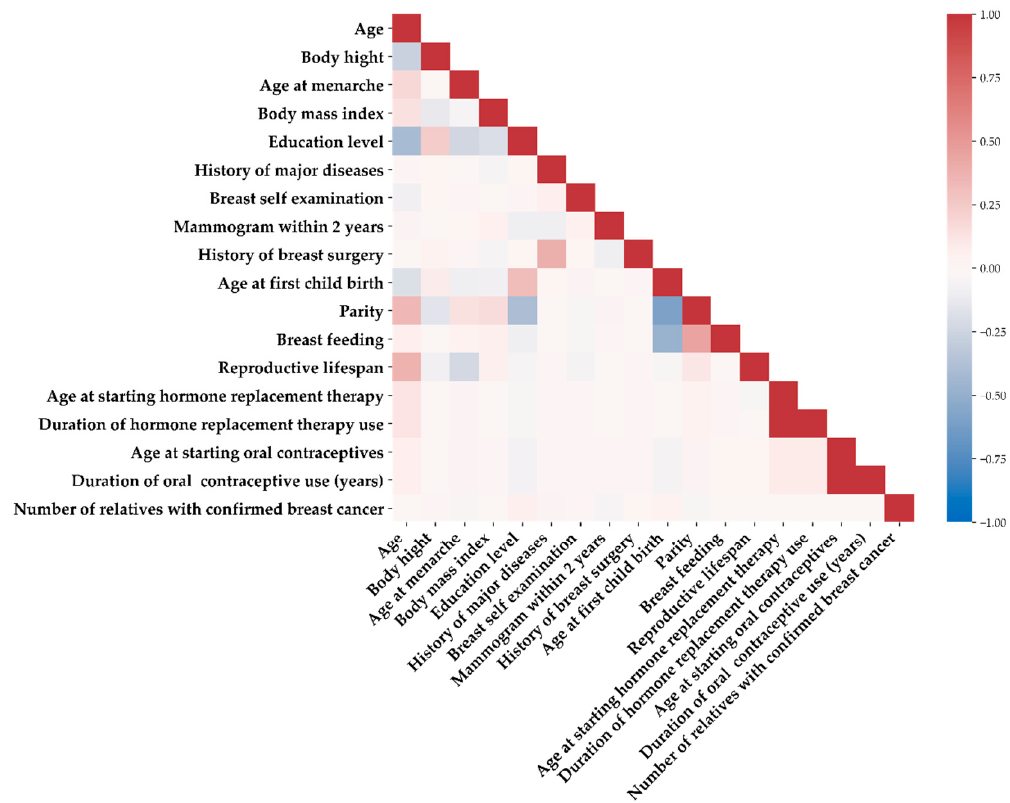
Figure 2. Heatmap visualization of the correlation matrix between the 18 variables.